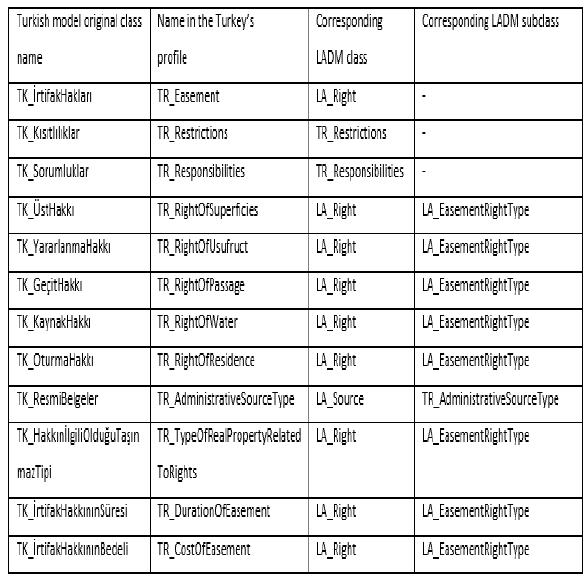
Table 1: The main classes of Turkish temporal cadastral data model classes of Turkey’s country profile and related ISO 19152 LADM classes.